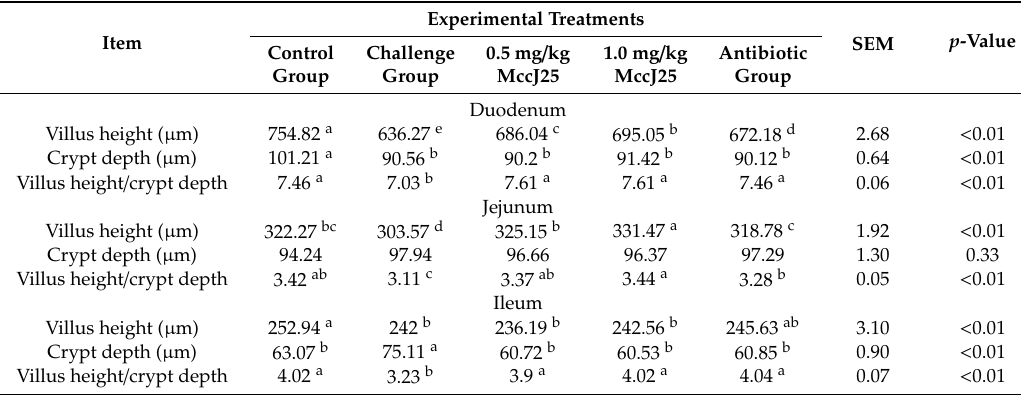
Table 4. E ff ects of MccJ25 on villus height, crypt depth, and villus height to crypt depth of duodenum, jejunum and ileum in broilers 1 .